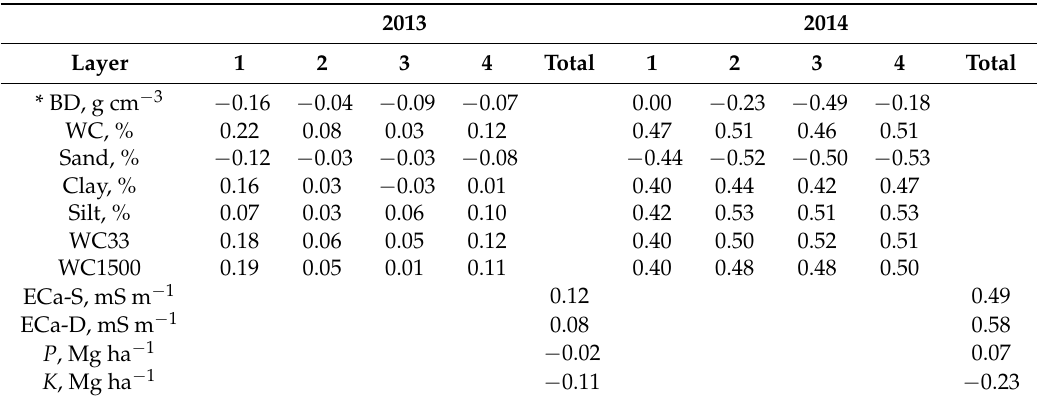
Table 7. Correlation coefficient values between cotton lint yield data (2013 and 2014 cropping seasons), soil properties at four depths from 0–1 m, and fertilizer application.